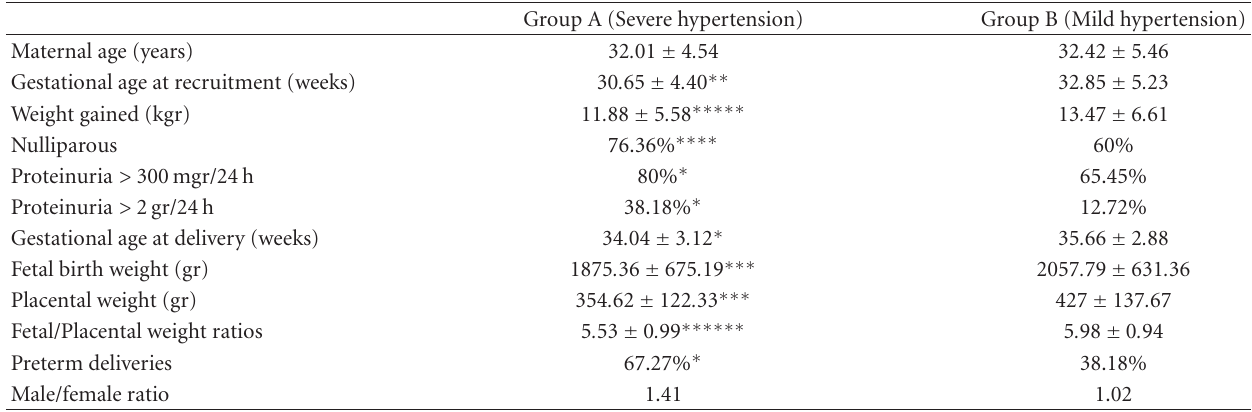
Table 1: Maternal, fetal and placental data.